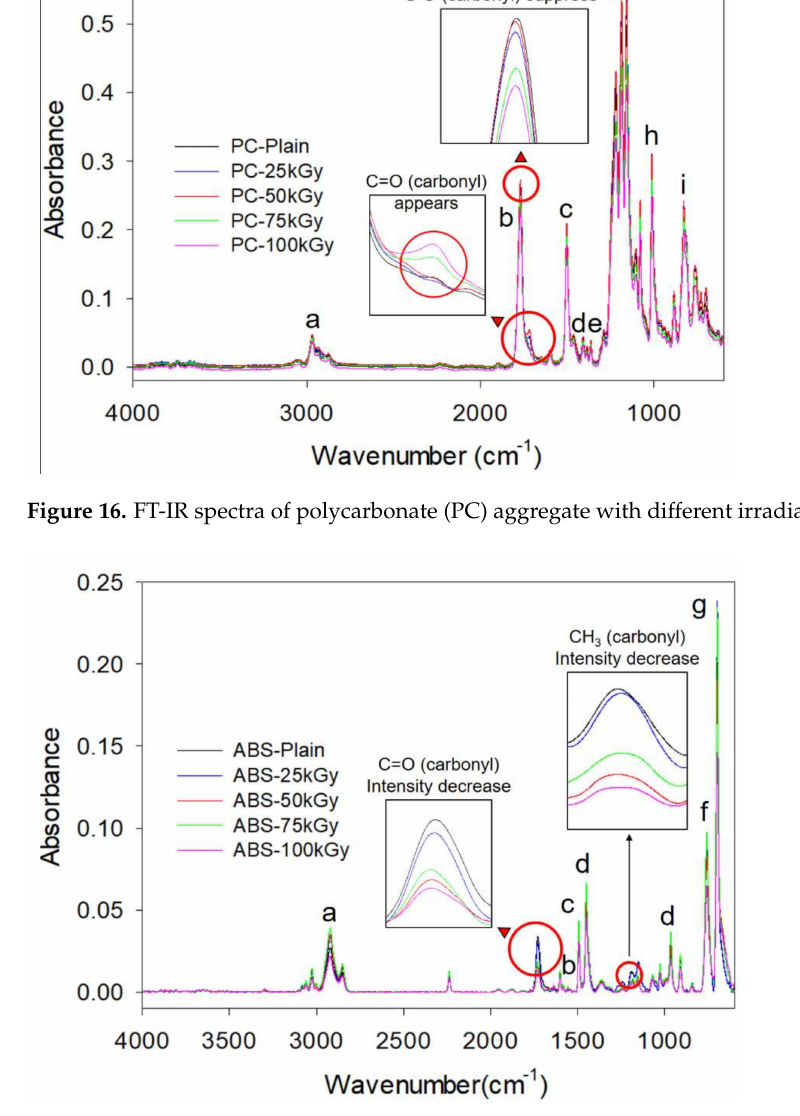
Figure 17. FT-IR spectra of acrylonitrile butadiene styrene (ABS) aggregate with different irradiation